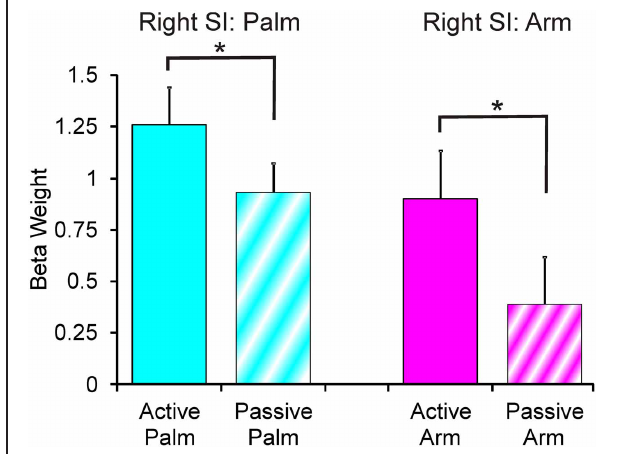
FIGURE 2 | Beta weights from the right SI palm and arm respective areas. There were significant differences for the palm SI BA03 region and arm SI BA03 region (see Table 1 for area details), where active stroking gave significantly higher beta values than passive stroking. Error bars show ± 1 standard